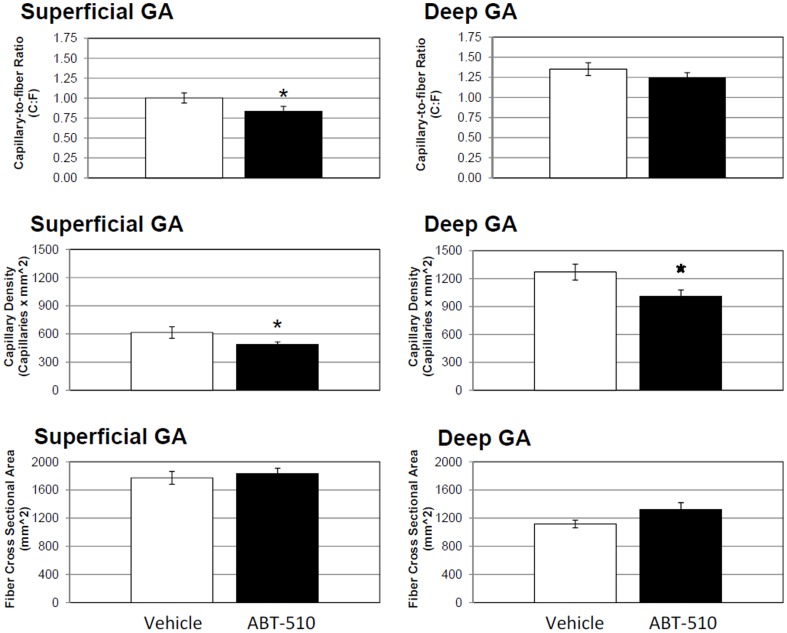
Superficial gastrocnemius capillarity, but not deep, is decreased in the ABT-510 group.Chronic administration of ABT-510 30 mg/kg/day decreased capillary to fiber ratio (C∶F) and capillary density (CD) in the superficial gastrocnemius (GA). Despite a similar trend, no significant changes in capillarity were seen in the deep GA. There was no change in fiber cross sectional area in either the deep or superficial portions of the GA. * = P≤0.05.